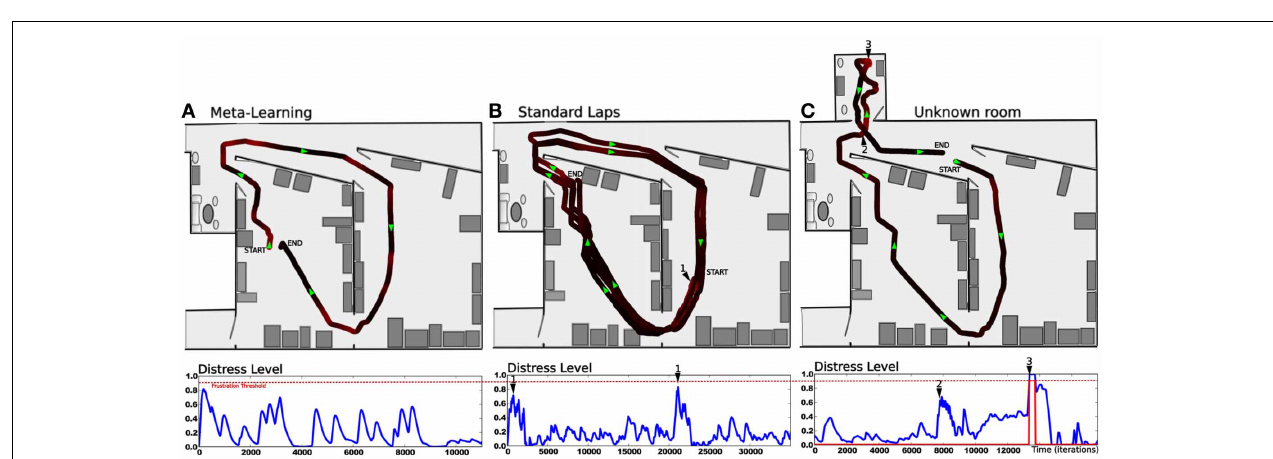
anything about the task. The metacontroller is OFF during this stage. (B) corresponds to the evaluation stage (second and third lap). The teacher evaluates the robot’s behavior and correct it only when needed. The metacontroller is ON and starts to learn to predict the sensory-motor sequences. Consequently, both novelty and progress levels are high during this stage. (C) corresponds to the final stage where the robot is autonomous enough to stop learning. Rare corrections are still needed at some points.